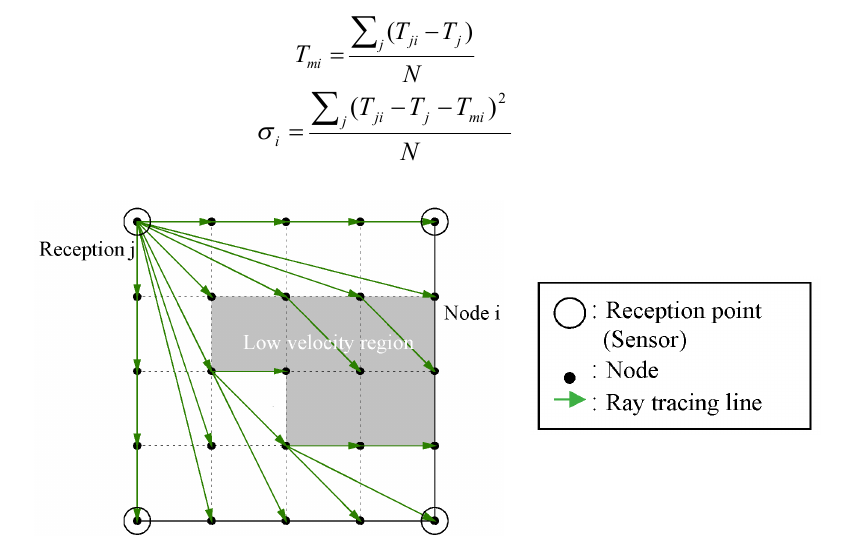
Figure 3. Overview of transmission source estimation using ray tracing.